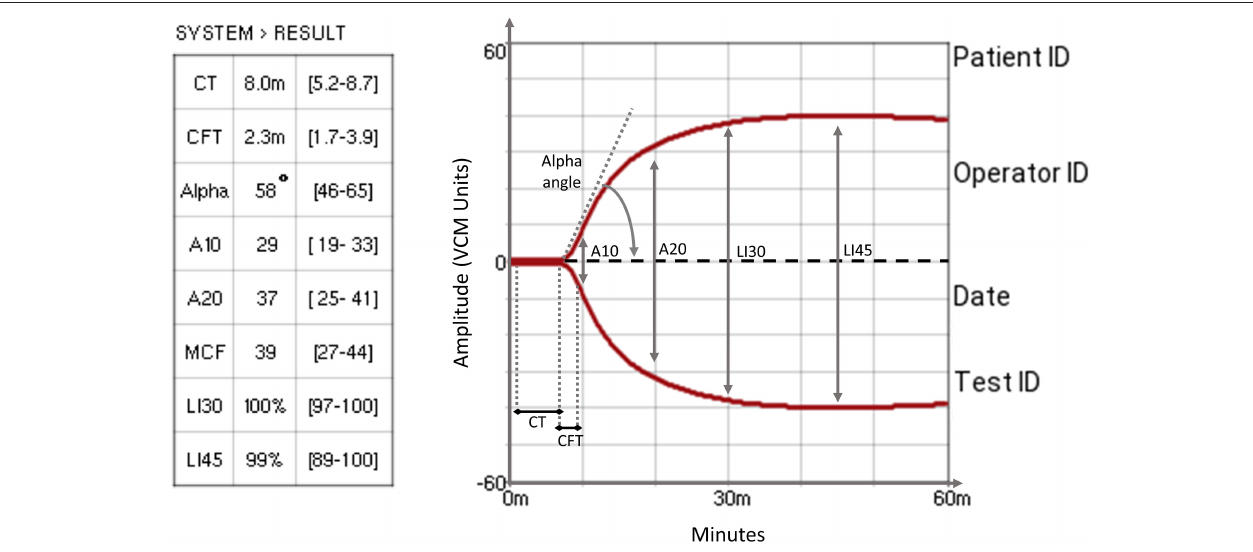
FIGURE 1 | A typical VCM trace that shows VCM measurement parameters. CT , clotting time: the time required to reach the clot amplitude of 1% above the baseline; CFT , clot formation time: the time required to pass from 1 to 10% amplitude of the clot signal, describing the kinetics of the clot; Alpha angle : the angle between the baseline and the tangent to the curve at an amplitude of 1%, describing the kinetics of the clot; A10 & A20 , amplitude at 10 and 20 min: clot amplitude measured at 10 and 20min, describing clot firmness; MCF , maximum clot firmness: the maximum amplitude reached before the beginning of fibrinolysis, describing the firmness and quality of the clot; LI30 & LI45 , lysis at 30 and 45 min: percentage clot amplitude at 30 and 45min referred to MCF